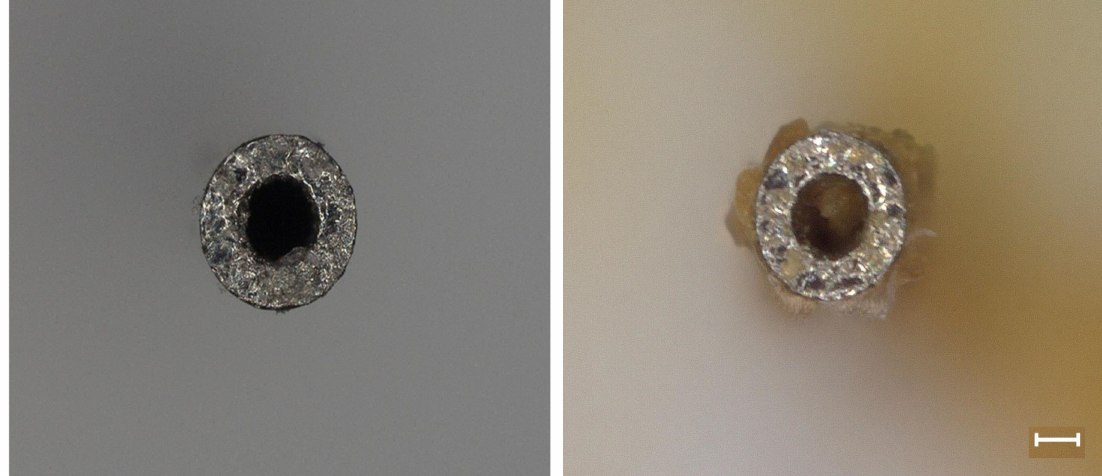
Figure 8. High Magnification Image of Explanted Cannula. The explanted cannulas seemed to show cellular debris and brain tissue on the inside of the cannulas, which may have caused the unstable drug delivery rate. Scale bar = 100 µ